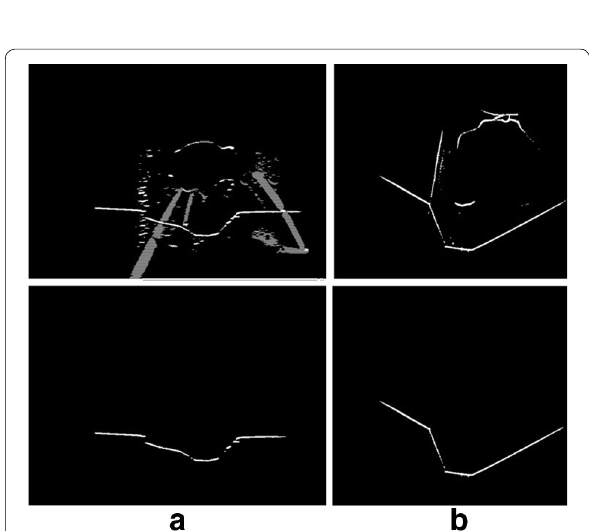
Figure 17 Verification results using the second simplified method: a filtering angles θ = ± 10 ◦ , 0 ◦ , b θ = ± 10 ◦ , − 80